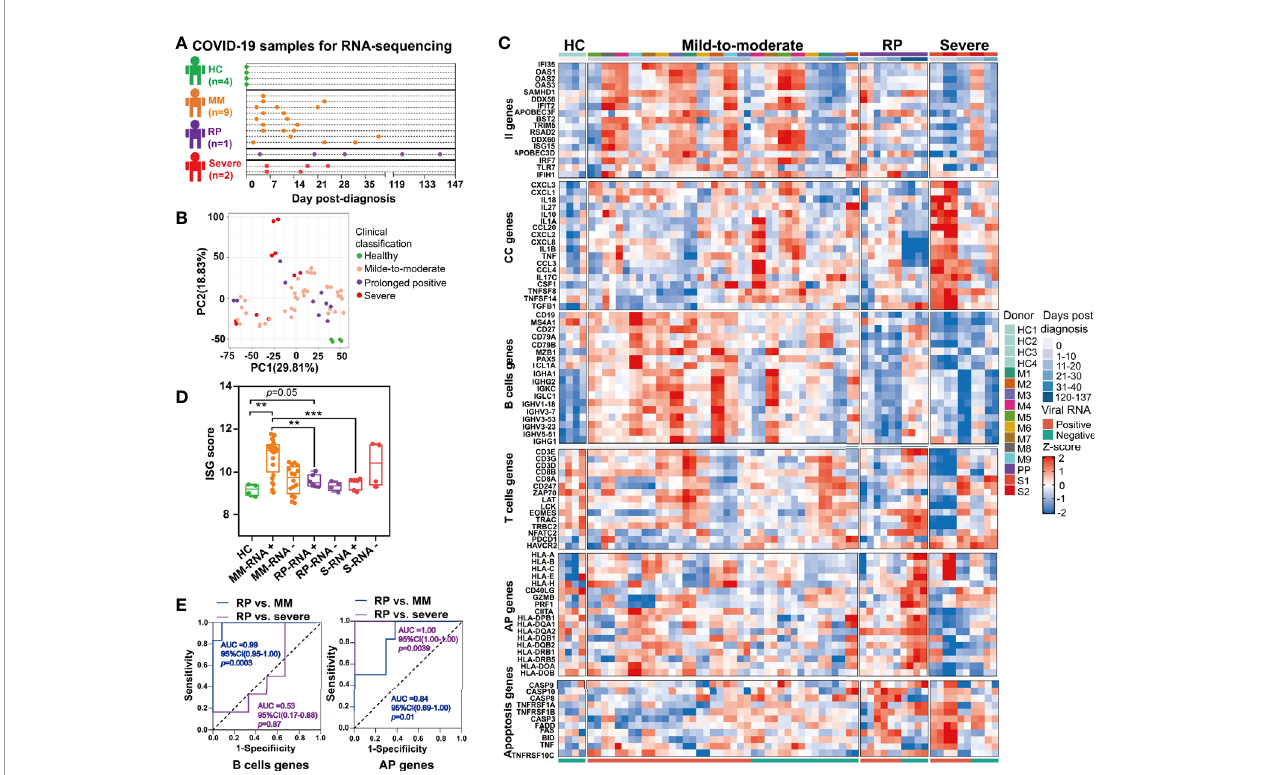
FIGURE 5 | Comparison of immune signatures between the SARS-CoV-2 RNA re-tested positivity (RP) patient and Mild-to-moderate (MM) patients or severe patients. (A) Schema of the RNA-seq experimental design. A total of 12 COVID-19 patients and four healthy controls (HC) were included in this study. (B) Unsupervised principal component analysis based on global gene expression. (C) Heatmap of a subset of innate immunity (II) genes, cytokine and chemokine (CC)-related genes, B cells- related genes, T cells-related genes, antigen presentation (AP) genes (including MHC class I-related genes and MHC class II-related genes) and apoptosis-related genes. (D) Comparison of interferon-stimulated genes (ISGs) scores between the PP patient and MM patients or severe patients. Asterisks represent signi fi cant differences between groups (** p -value < 0.01, *** p -value < 0.001, unpaired t-test). (E) Receiver-operating characteristic curve of the clinical course prediction based on the expression of B cells-related genes and antigen presentation (AP)-related